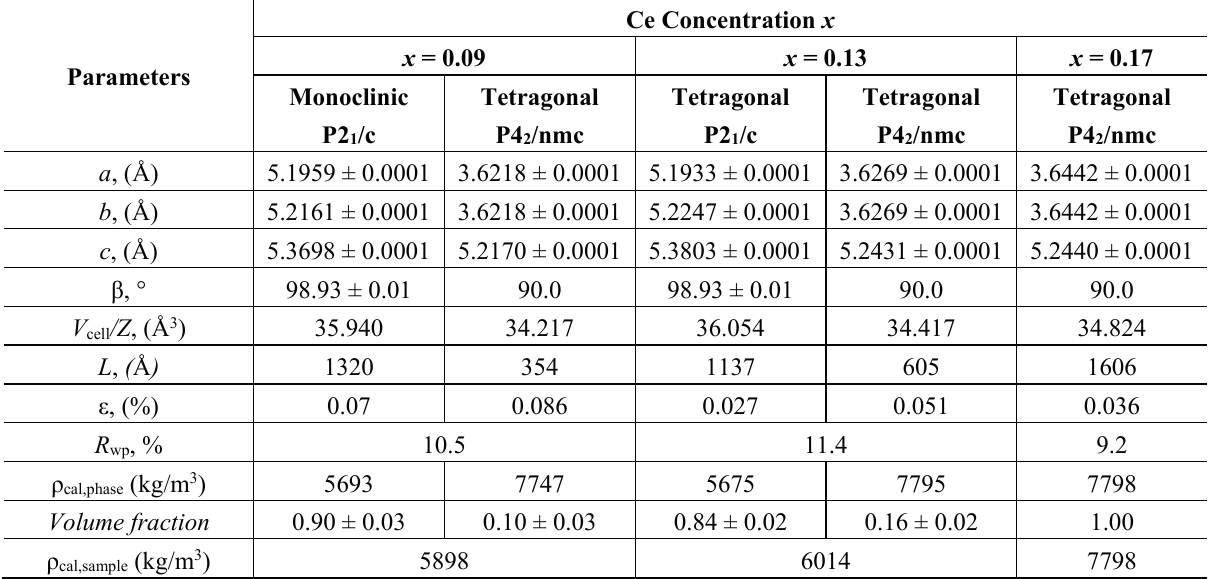
Table 3. Lattice constants (a, b, c, β ), unit cell volume (V cell ), average size of crystalline blocks ( L ), microstrains ( ε ), and calculated densities ( ρ cal,phase ) and observed densities ( ρ cal,sample ) of each phase and each Zr 1- x Ce x O 2 ( x = 0.9–0.17) sample at room temperature, obtained by processing the data collected with the Bruker Advance diffractometer (XRD